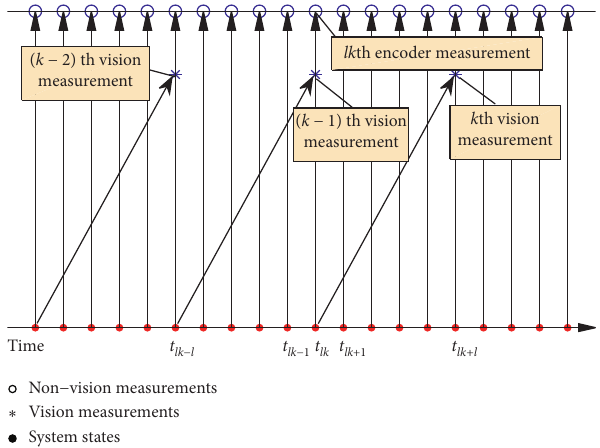
Figure 1: The schematic diagram of the relation between vision and non-vision